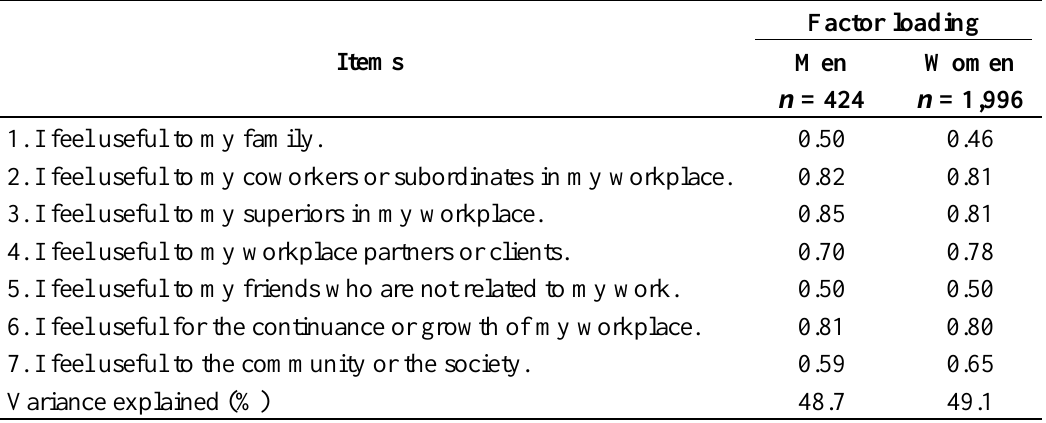
Table 2. Exploratory factor analysis of items of the Sense of Contribution Scale using a least squares method and Promax